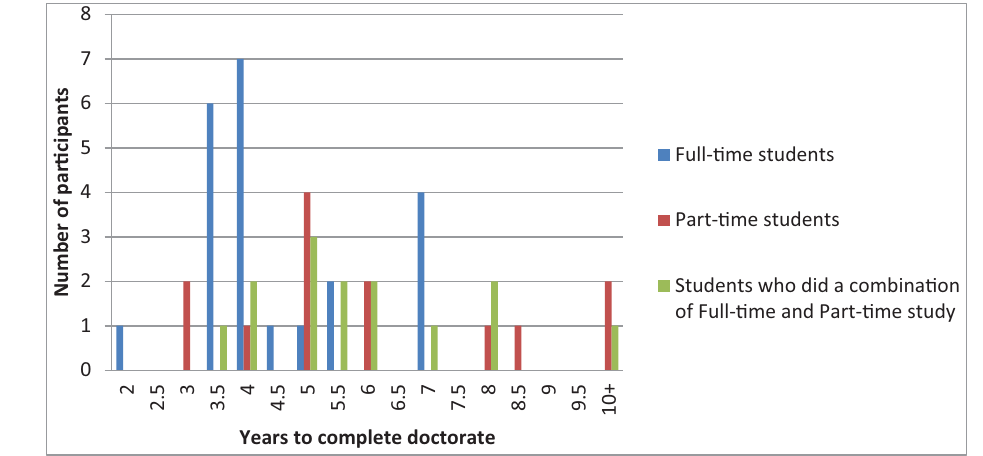
(Colour online) Length of time to complete doctoral